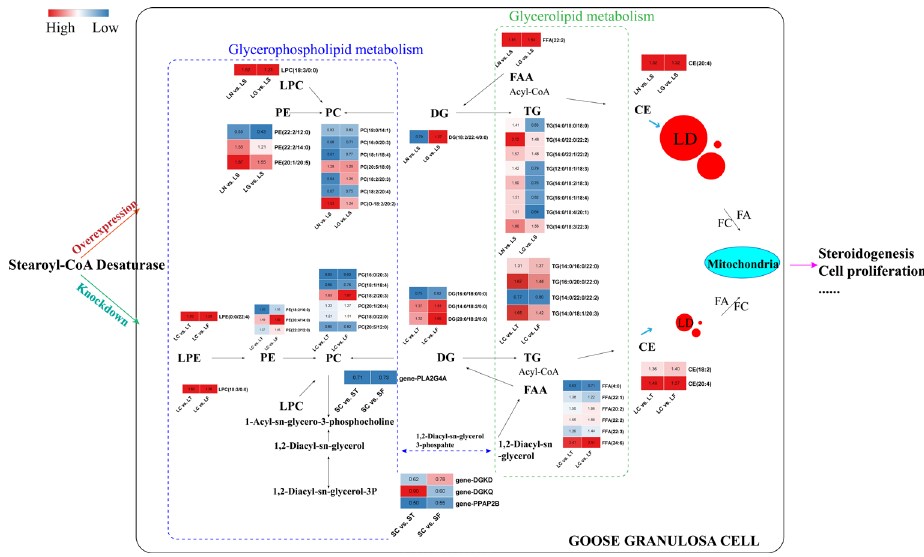
Figure 4. Diagram of stearoyl-CoA desaturase ( SCD ) regulation of key lipids and differentially expressed genes (DEGs) in glycerophospholipid metabolism and glycerolipid metabolism, which participate in steroidogenesis mediated by the deposition of lipid droplets in goose granulosa cells (GCs). Numbers in the heat map indicate the FC of the key lipids and DEG in the group; the color scale indicates the difference in FC; red, higher; blue, lower.